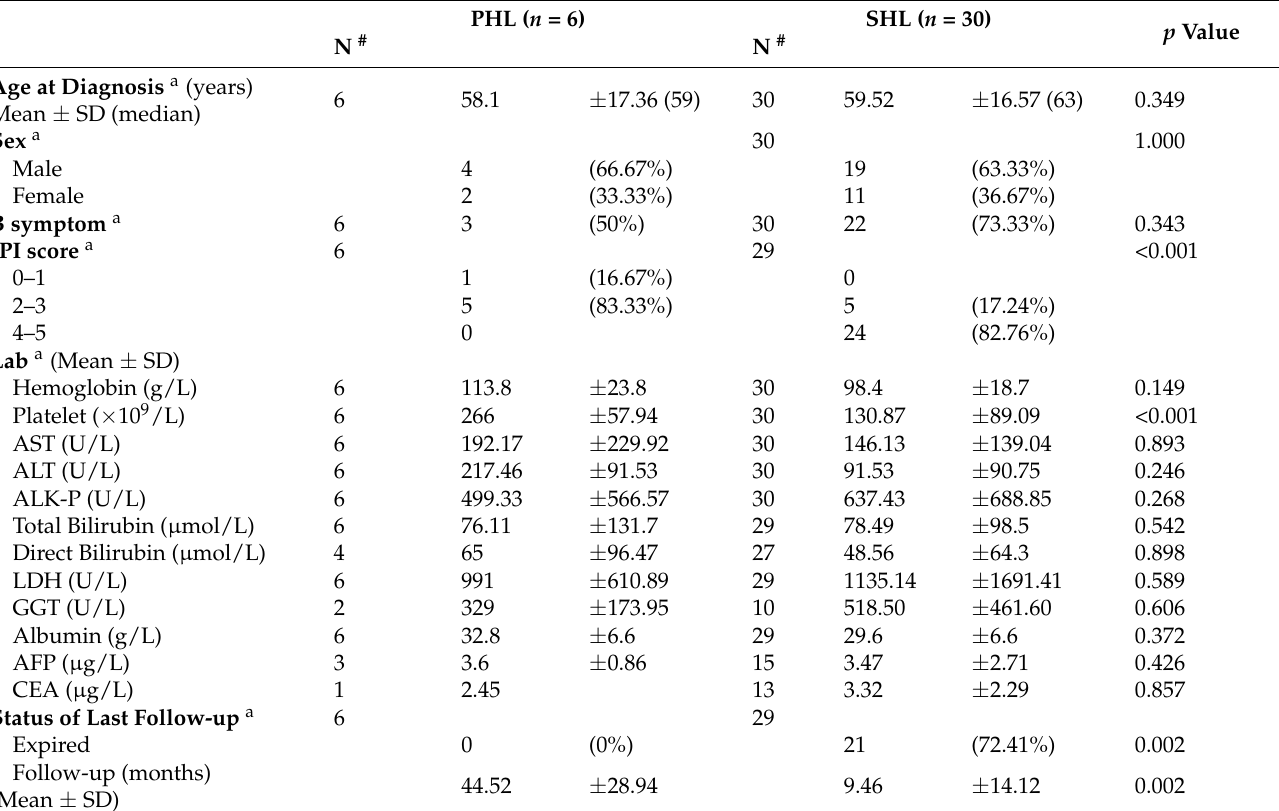
Table 2. Demographic and Laboratory